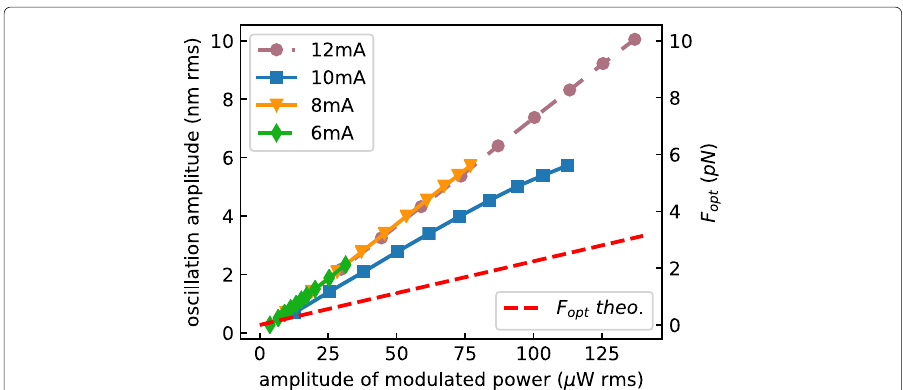
Fig. 7 Cantilever oscillation amplitude as a function of modulation power at varying laser diode currents (solid lines). The right vertical axis indicates the corresponding optical force. The red dashed line shows the theoretical optical scattering